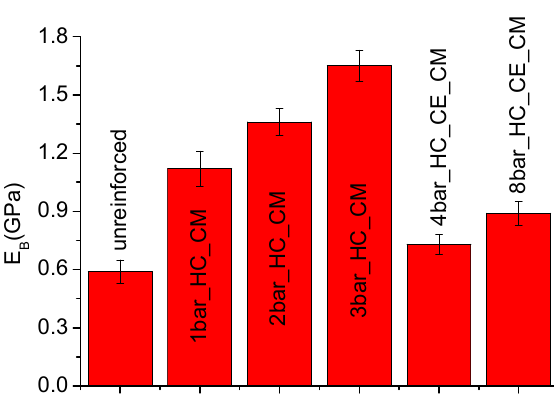
Figure 8. Equivalent bending modulus of unreinforced and reinforced plates.